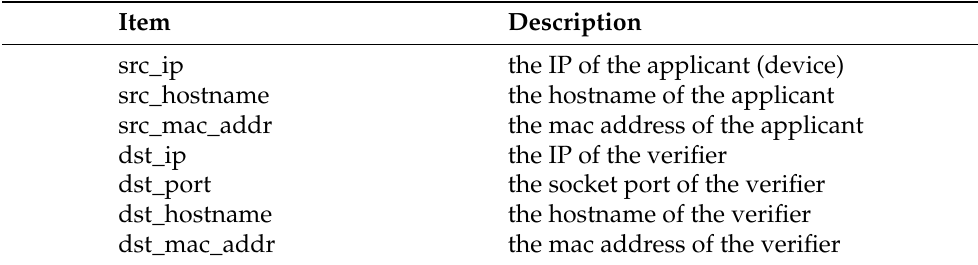
Table 1. The information for applying token.